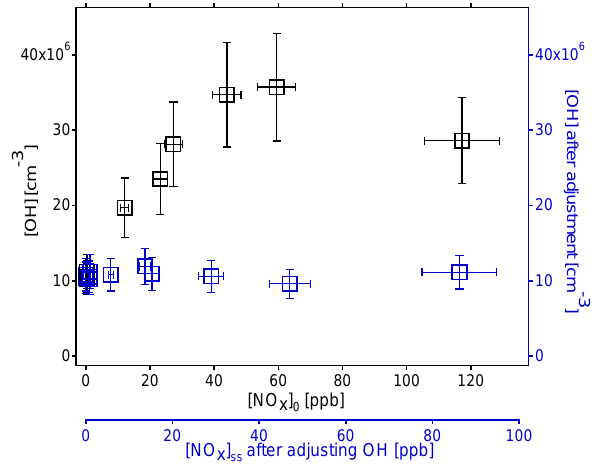
Figure 5. Comparison of SOA yield before (black circles) and af- ter (blue circles) adjusting OH concentration during steady state in NO x experiments. The error in [NO x ] was estimated to be ± 10% and the error in SOA yield was estimated from error propagation us- ing the sum of the systematic error, correction procedure error and error in BVOC